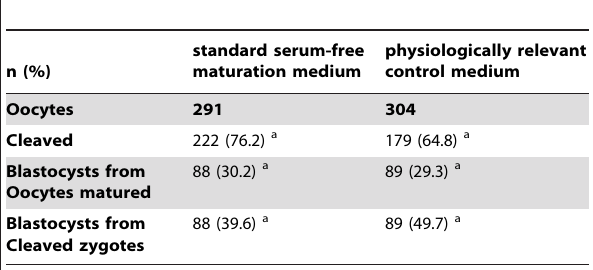
Table 2. Validation of a physiological relevant control